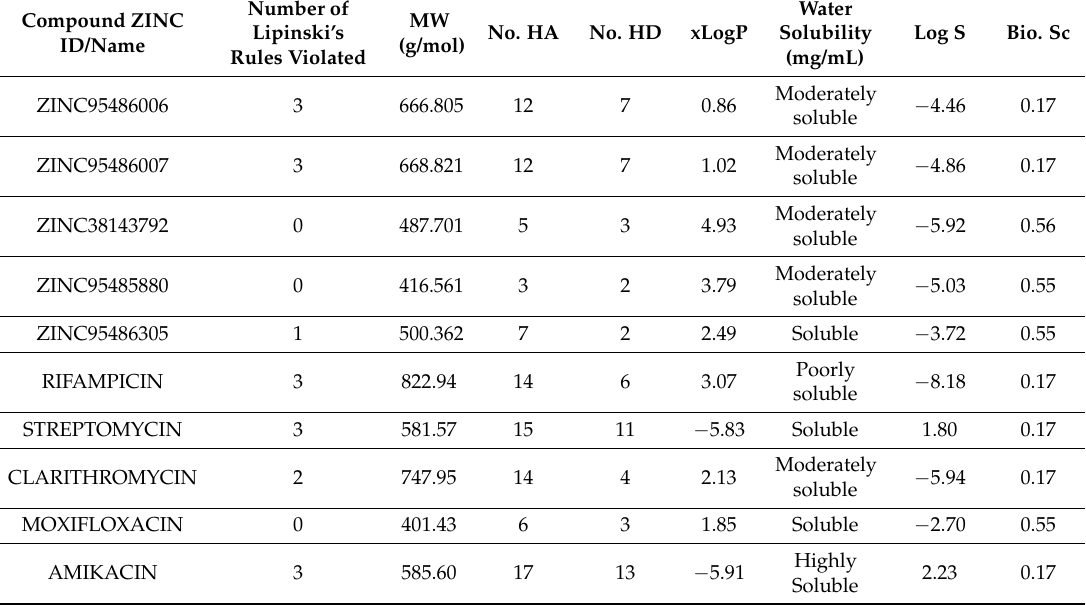
Table 3. Drug-likeness and water solubility of the top five (5) hits and five (5) known drugs (where No. HA = Number of H-bond acceptors, MW = Molecular weight, No. HD = Number of H-bond donors, Bio Sc = Bioavailability